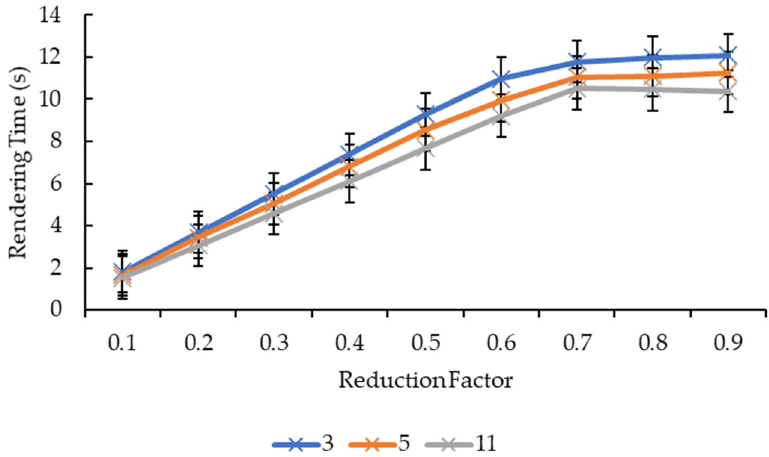
Figure 14. Graph of rendering time against reduction factor for convolution kernel Gaussian.